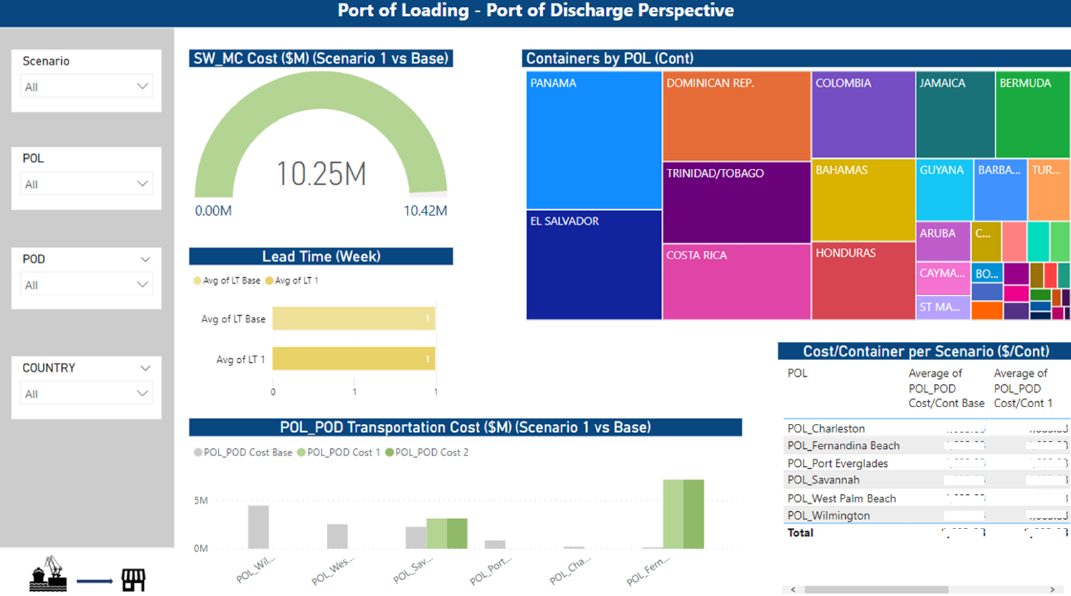
Figure A3. Summary of Mixing Center to Port of Loading Perspective. The legend corresponds to the notation introduced in Section 4.3.1. The values for current rates, new contract assumptions, and costs are sensitive data and intentionally covered.